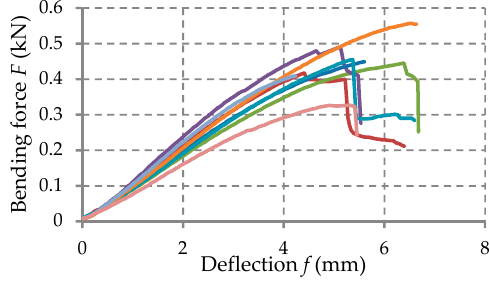
Figure 10. Force–deflection ( F − δ ) curves obtained in case of the OSB flexural specimens.